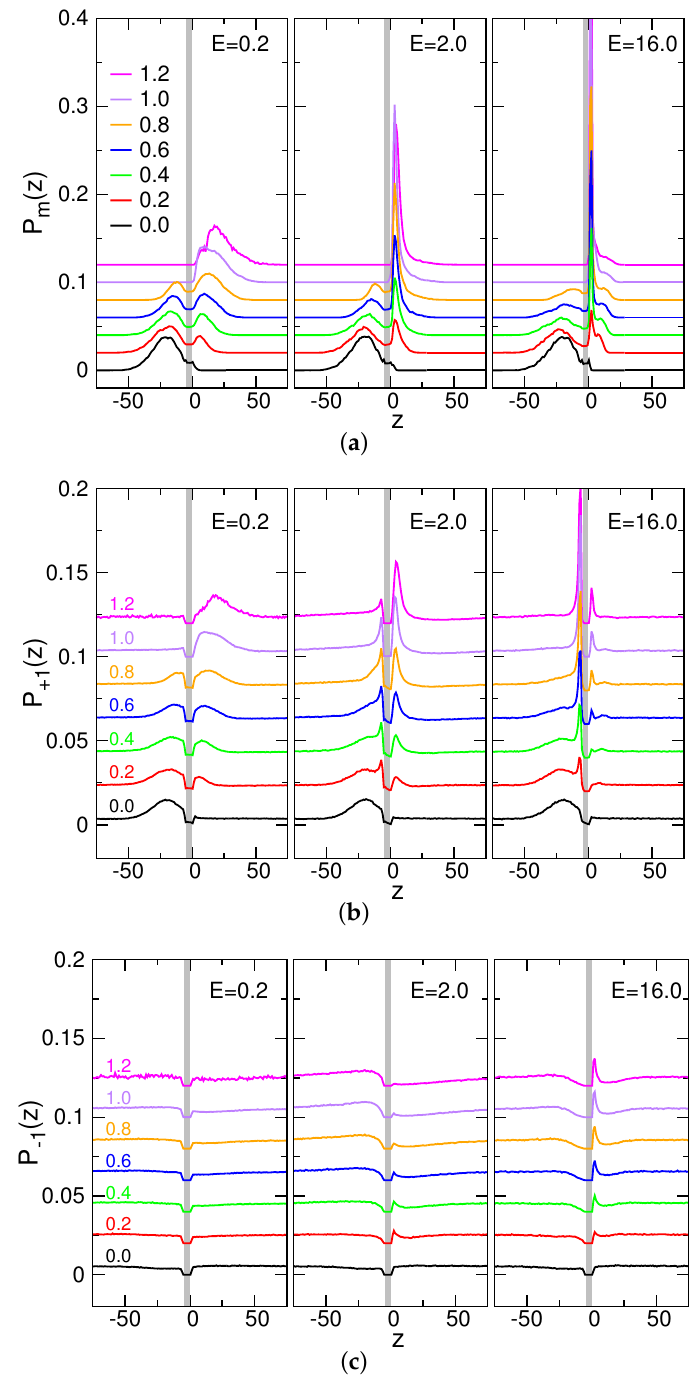
Figure 10. Probability distributions in the z -direction for ( a ) monomers; ( b ) counterions; and ( c ) coions; at E = 0.2, 2.0, and 16.0 ( N = 128). The gray color denotes the z -location of the pore. The value given near a curve is the normalized time ˜ t at which the probability density was calculated. For clarity, the curves have been shifted upward with a fixed step value, one curve after the